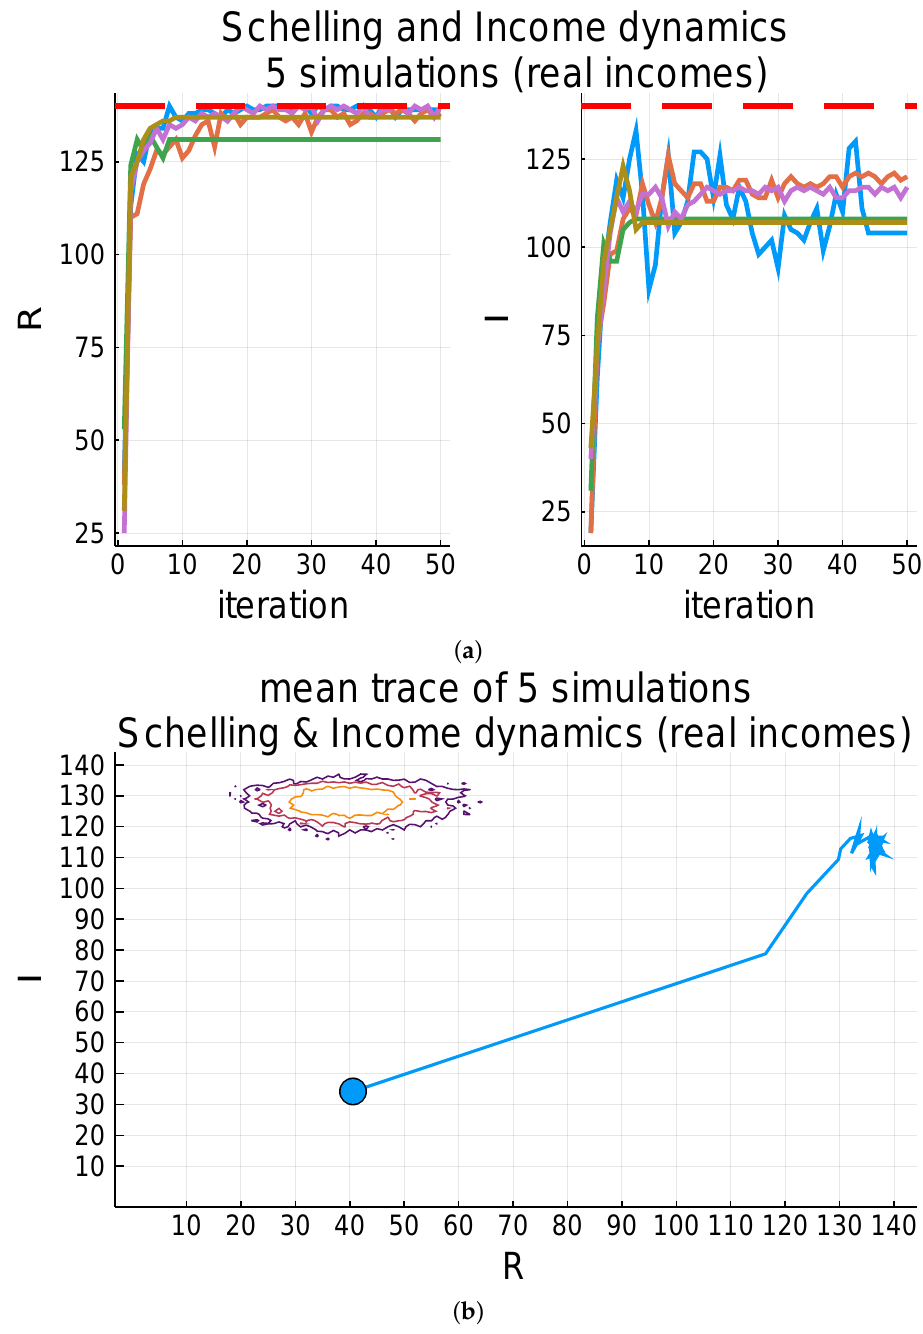
Figure 6. A higher dependence of the income homogeneity to the residential homogeneity presents itself at the later stages of the simulation due to the increased spending of the upper class. Subfigure ( a ) shows the trajectory of the overall grid homogeneity over simulation iterations for R and the grid income homogeneity I for the same iterations. Subfigure ( b ) shows the trajectory over both homogeneity variables with the contour levels of the sampled density of the space used to calculate the entropy of each point in the trajectory. Equation (11) was used for residential